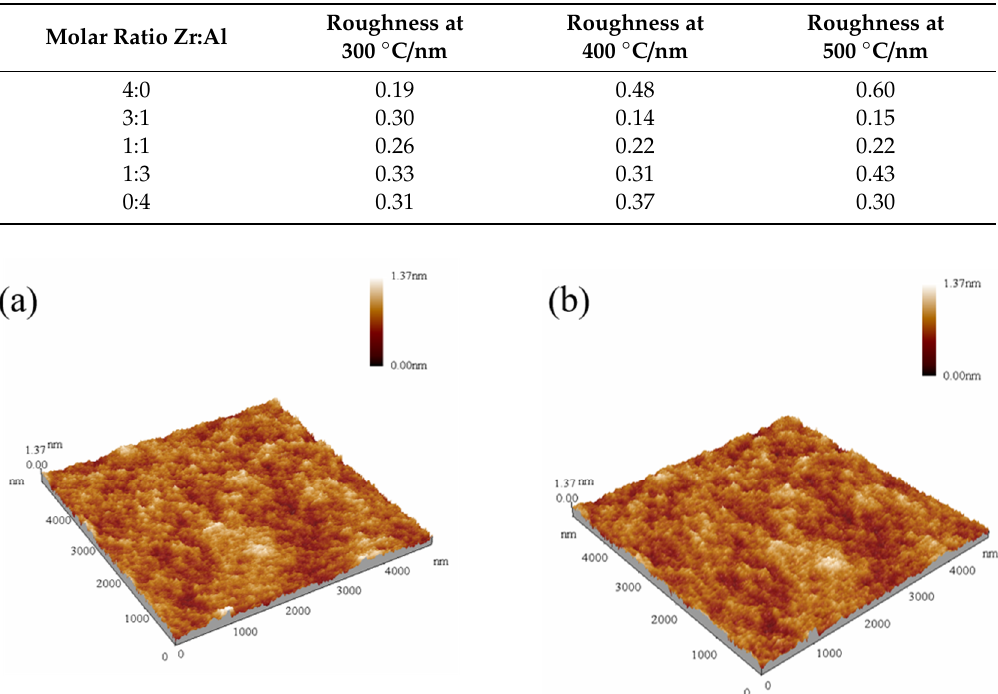
Table 4. The roughness of the films calculated from the AFM results.